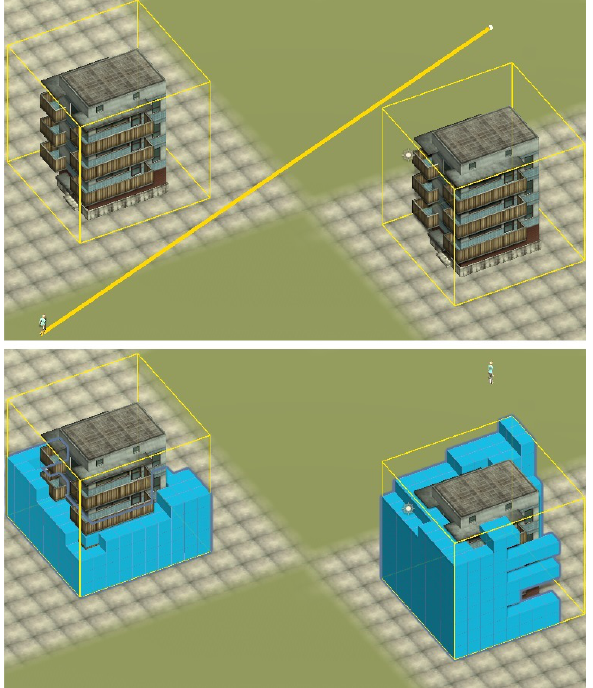
Figure 7. Understanding intervisibility for exterior of buildings.